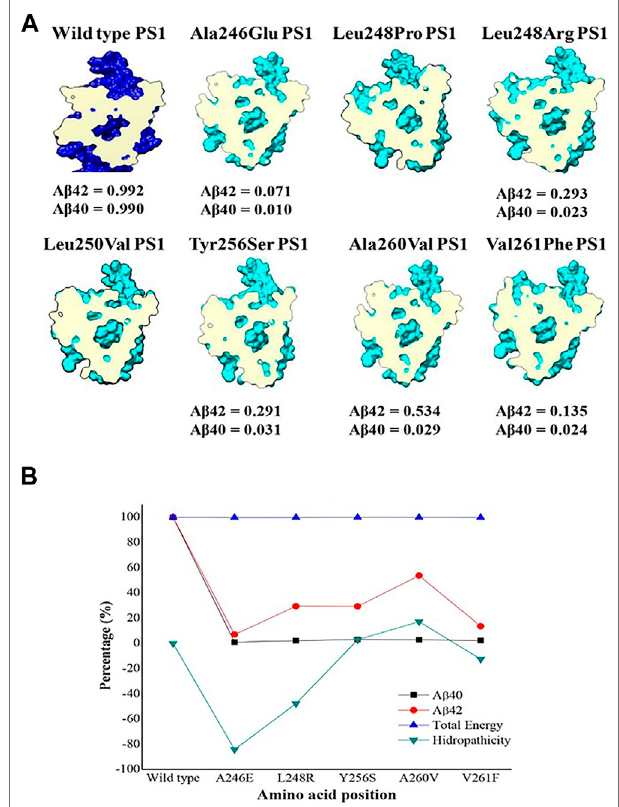
FIGURE 6 | Top view section of wild-type PS1(dark blue) and the seven mutations analyzed in TM6 (pale blue)witha cross section at thesamelevel of thecatalyticpocket(magenta). (A) β ratiovalueswereobtainedfromreference (Sun et al., 2016); (B) Energy comparison plot, hydrophobicity and total amount of amyloid